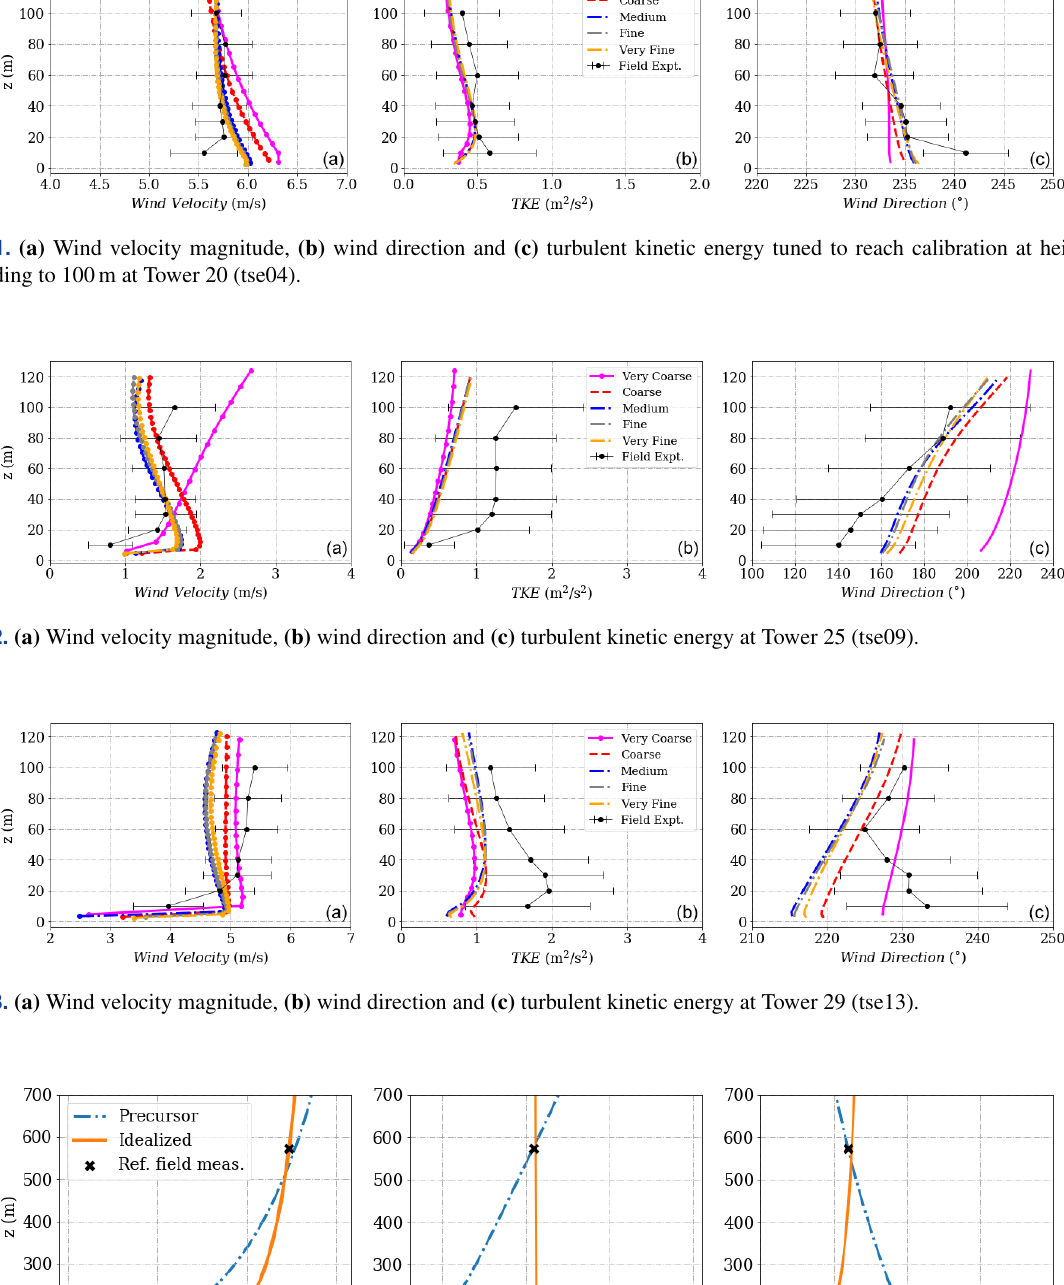
https://doi.org/10.5194/wes-8-85-2023 Wind Energ. Sci., 8, 85–108,